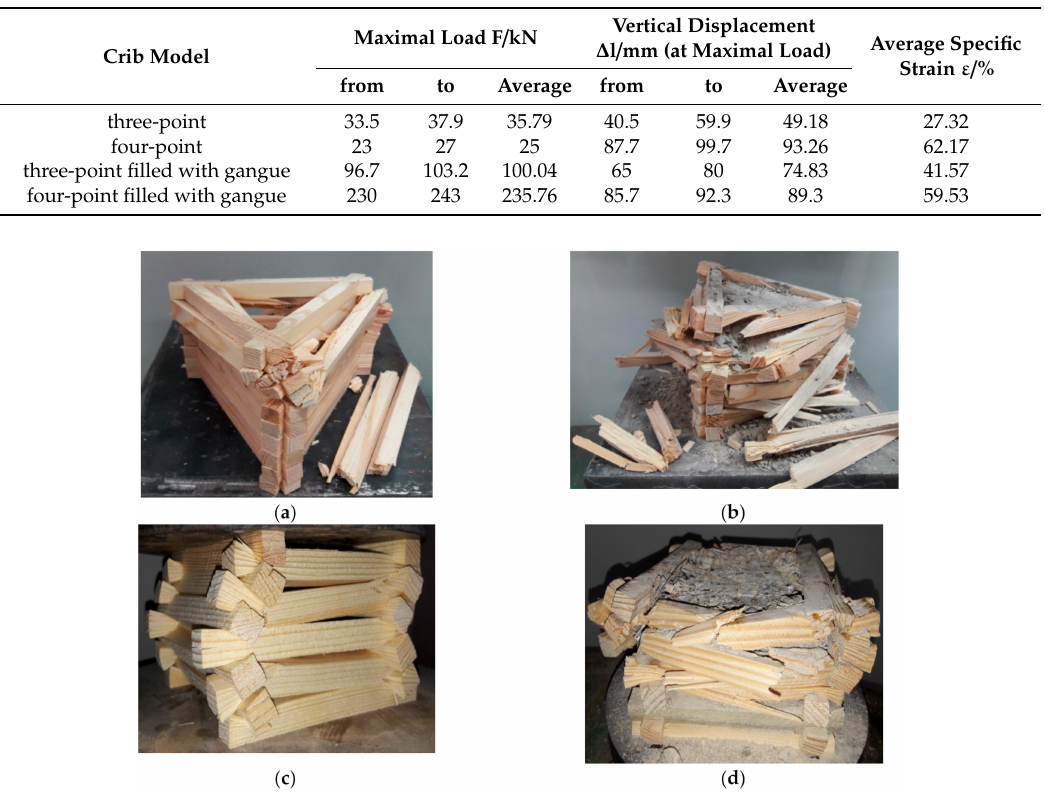
Figure 8. Wooden cribs models after compression test: ( a ) Three-point; ( b ) Three-point filled with gangue; ( c ) Four-point; ( d ) Four-point filled with